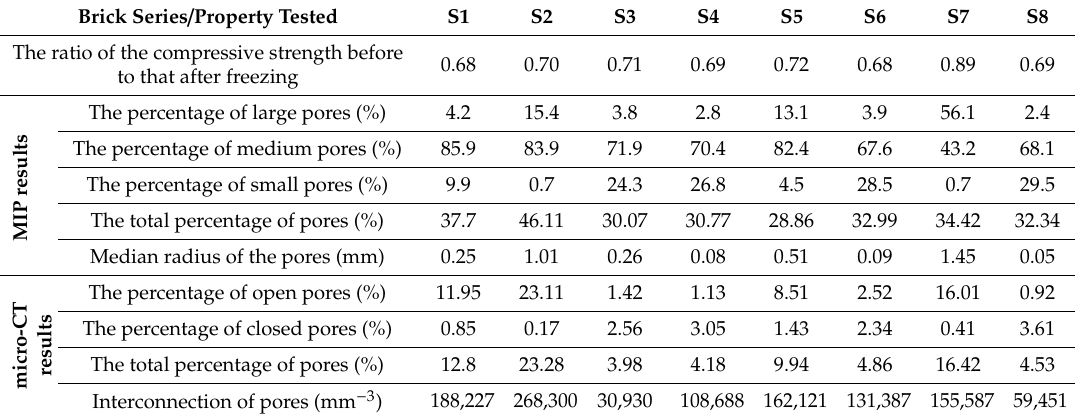
Table 5. Summarized results of the brick resistance to freeze-thaw cycles, porosimetry and micro-CT. Brick Series / Property Tested